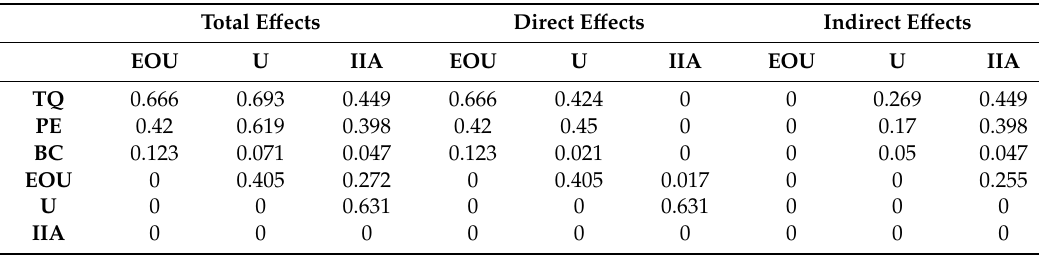
Figure 4. The validation results of the proposed model. + p < 0.1, * p < 0.05, ** p < 0.01, *** p < 0.001. Table 11. Direct, indirect and total e ff